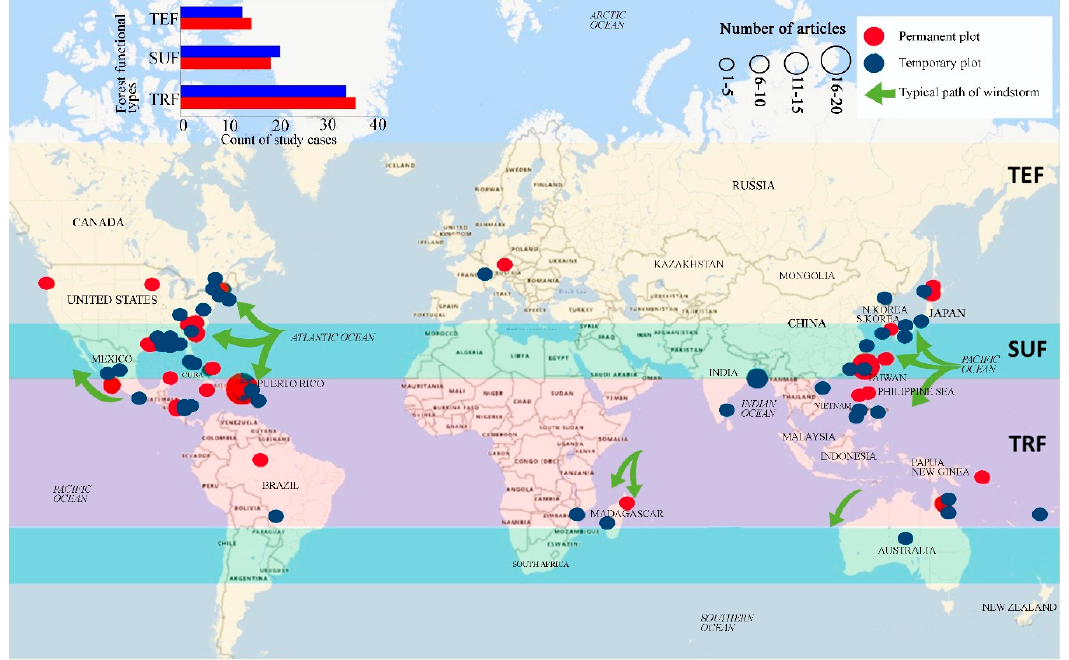
Figure 2. The number of study cases and global distribution of studies conducted in permanent/experimental and temporary plots in TRF, SUF, and TEF. The size of the dots is proportional to the number of studies for each type of